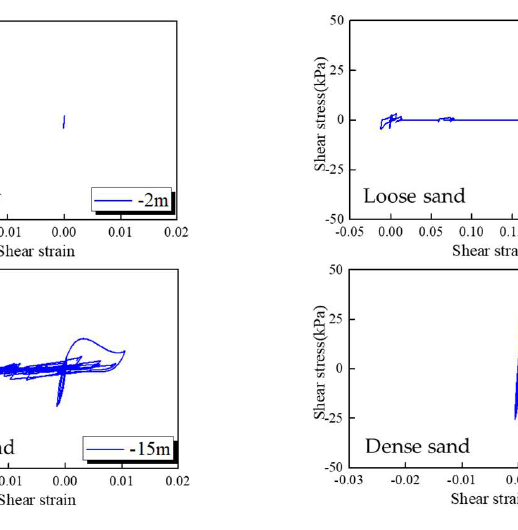
Figure 4. Shear stress–strain curves under the El-Centro motion.